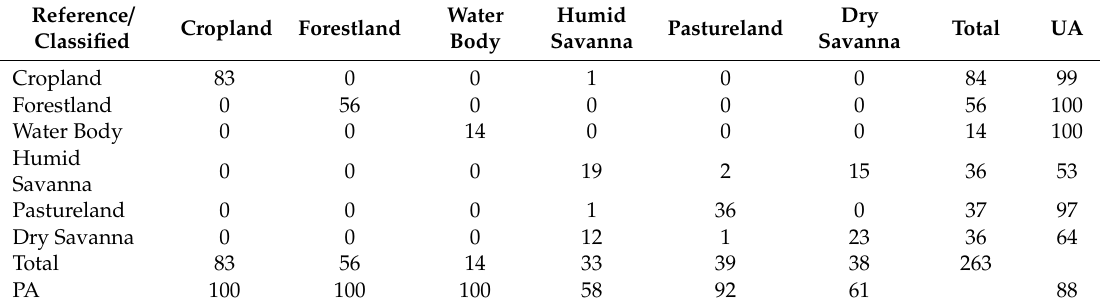
Table 4. Confusion matrix among the major land use and land cover classes with the MapBiomas